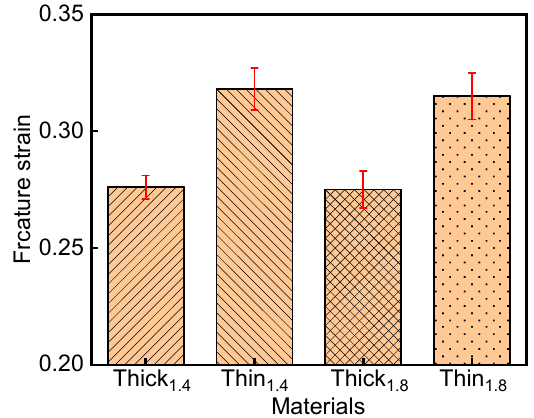
Figure 10. Fracture strain of the four Al–Si-coated steels.